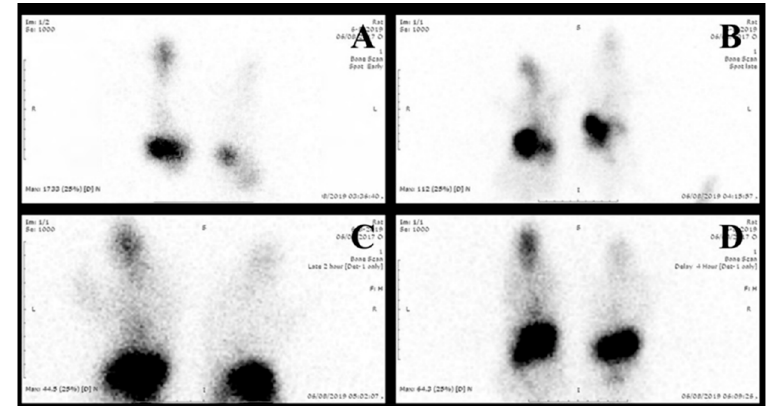
Figure 9. Serial anterior planar images of two rats at ( A ) 30 min, ( B ) 1 h, ( C ) 2 h, and ( D ) 4 h. The right one received 77.5 µCi of the oral Tc-99m labeled temazepam NLC-1 formulation; the left one received 77.5 µCi of the Tc-99m labeled temazepam oral suspension. All of the images showed higher uptake of the brain of the right one.